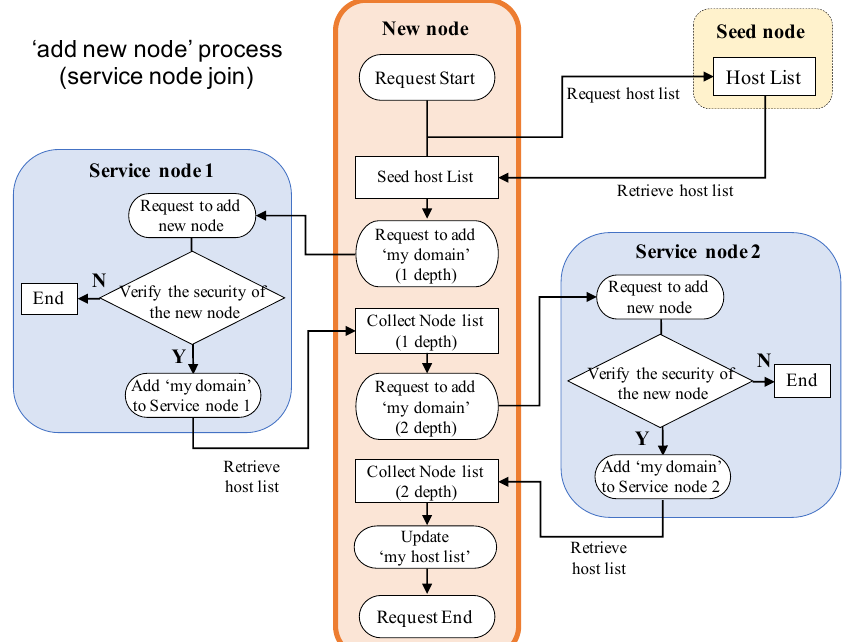
Figure 3. The process of ‘adding new node’.